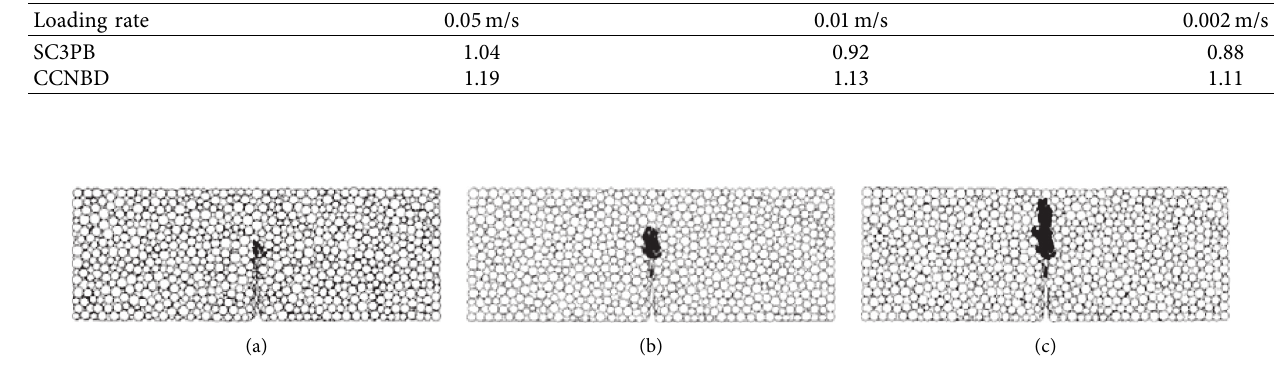
Figure 12: Microcracks distribution in SC3PB specimen (A1). (a) Crack initiation. (b) Crack growth. (c) Specimen failure.